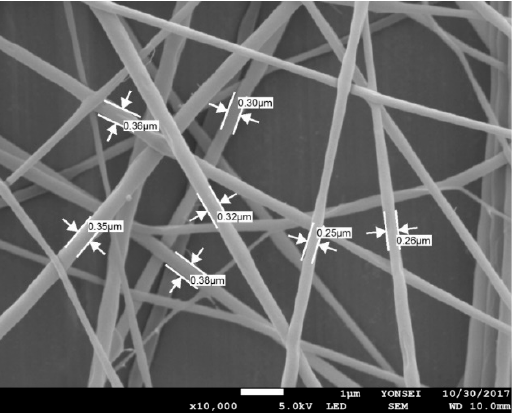
Figure 3. SEM images of cinnamon oil-containing PVA nanofibers produced under different processing conditions: ( a ) 0.2 mL/h, 23 G, ( b ) 0.2 mL/h, 25 G, ( c ) 0.5 mL/h, 23 G, ( d ) 0.5 mL/h, 25 G, ( e ) 0.8 mL/h, 23 G, ( f ) 0.8 mL/h, 25 G, ( g ) 1.2 mL/h, 23 G, and ( h ) 1.2 mL/h, 25 G. Applied voltage and tip-to-collector distance were maintained constant at 25 kV and 20 cm, respectively.